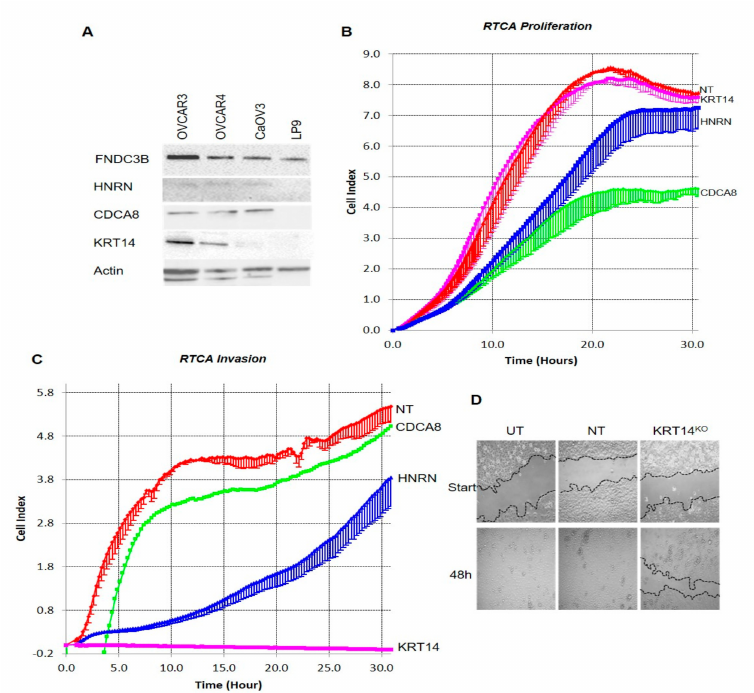
Figure 3. ( A ) Western blot analyses demonstrating the endogenous expression of MALDI identified candidates FNDC3B, HNRN, CDCA8, or KRT14 in ovarian cancer cell lines or the mesothelium LP-9. ( B ) RTCA proliferation assays. Representative results from OVCAR4 real-time proliferation